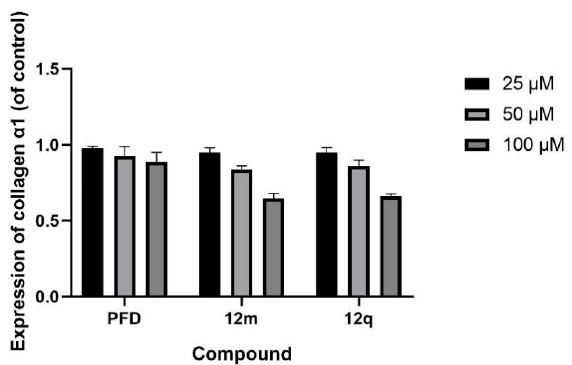
Figure 4. The e ff ect of PFD , 12q and 12m on the expression of collagen α 1 in HSC-T6 cell Figure 4. The effect of PFD , 12q and 12m on the expression of collagen α 1 in HSC-T6 cell line.